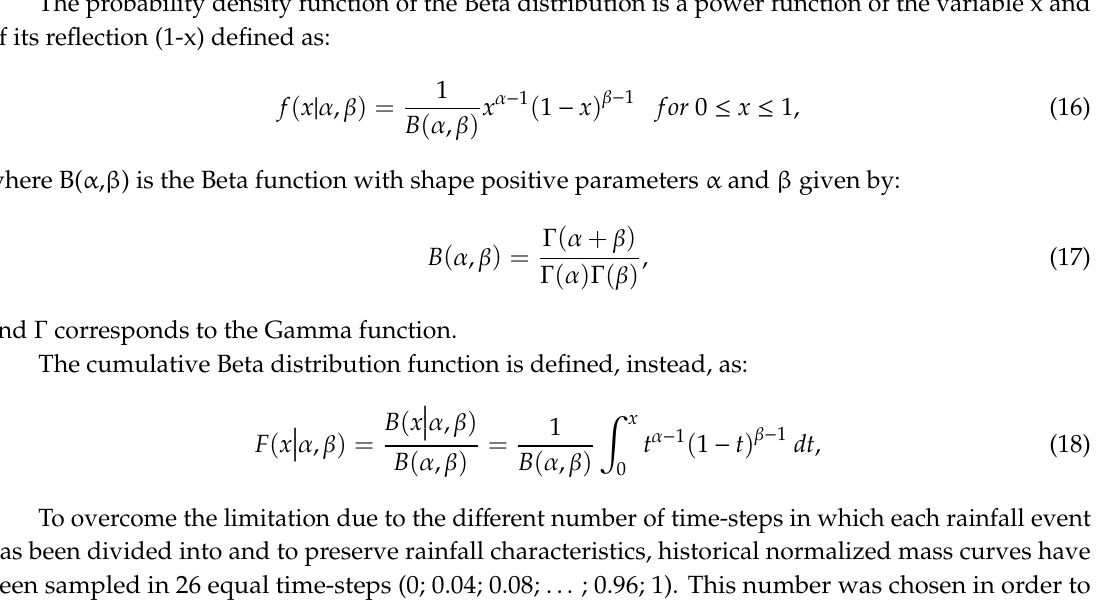
Figure 7. Dimensionless hyetographs for the selected events at: ( a ) Monreale; ( b ) Palazzolo